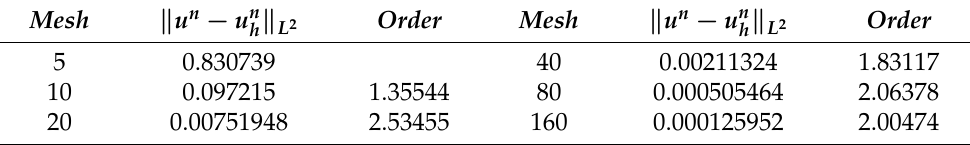
Table 2. Numerical errors and convergence rates for Experiment 2.